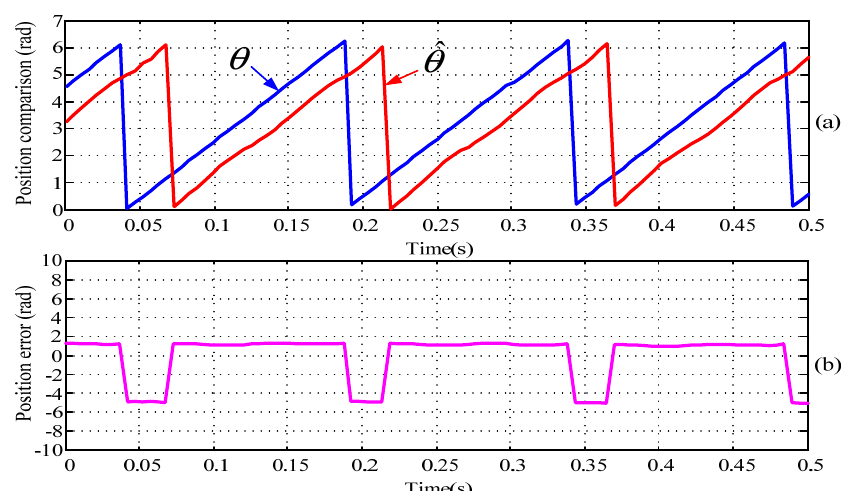
θ ) and rotor angle